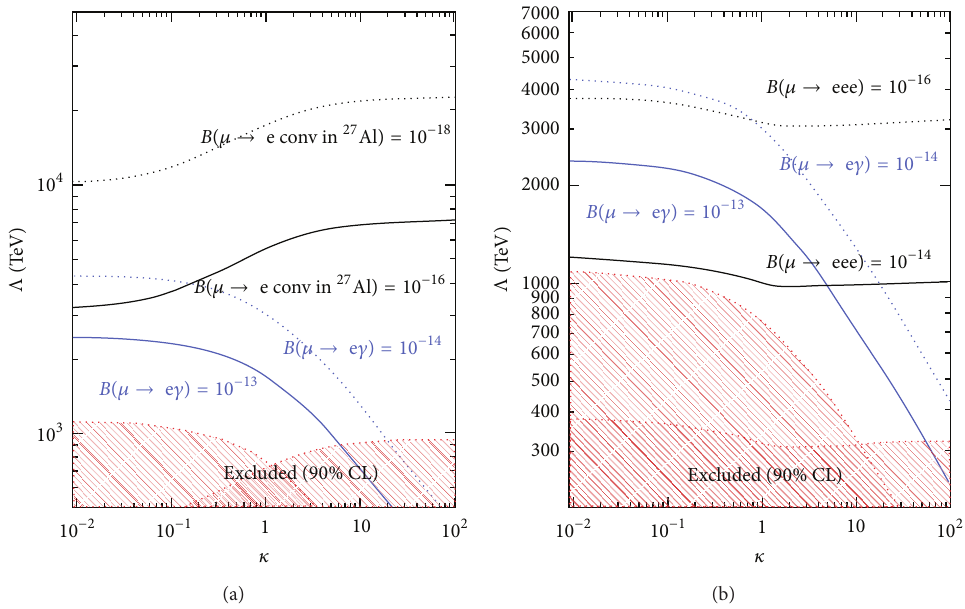
Figure 9: (a) Sensitivity of 𝜇 → e 𝛾 (blue) and 𝜇 − 𝐴 → e − 𝐴 conversion experiments (black) in the (𝜅,Λ) plane as predicted from formula (3). (b) Sensitivity of 𝜇 → eee (black) and 𝜇 → e 𝛾 (blue) in the (𝜅,Λ) plane as predicted from formula (4). The pink regions are excluded by MEG for small 𝜅 and by SINDRUM and SINDRUM II for large 𝜅 [78].